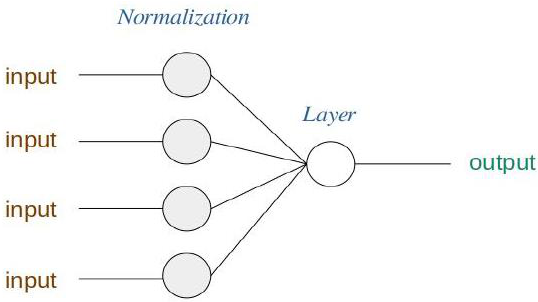
Figure 1. First Neural Network design. Prepared by the authors.